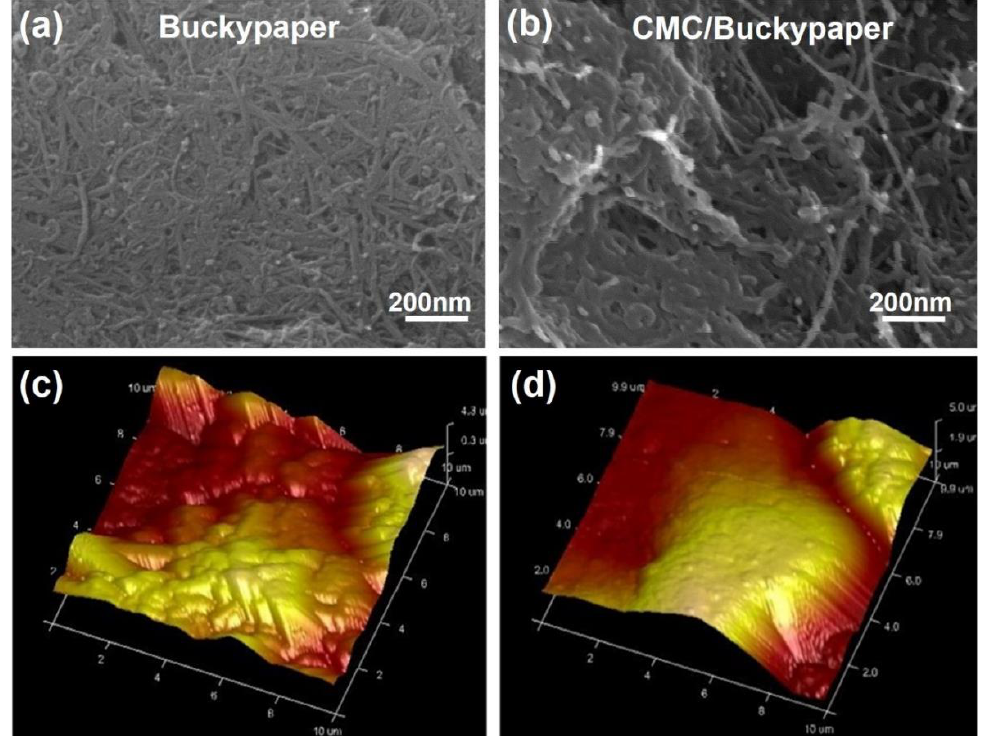
Figure 2. The morphology and structure of a buckypaper. ( a ) SEM picture of buckypaper; ( b ) SEM picture of CMC/buckypaper; ( c ) atomic force microscope (AFM) picture of buckypaper; ( d ) AFM picture of CMC/buckypaper.